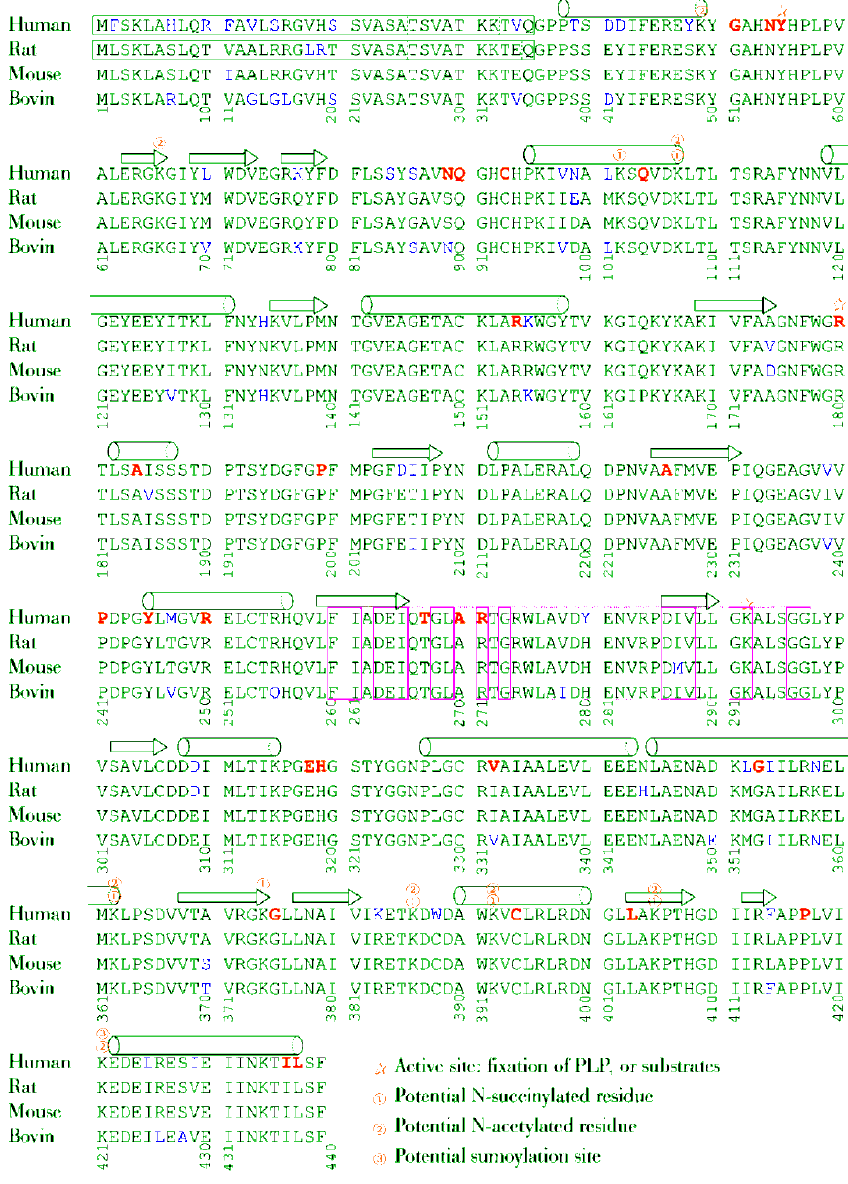
Figure 8. Amino acid sequence alignment of human, rat, mouse and ox OAT.